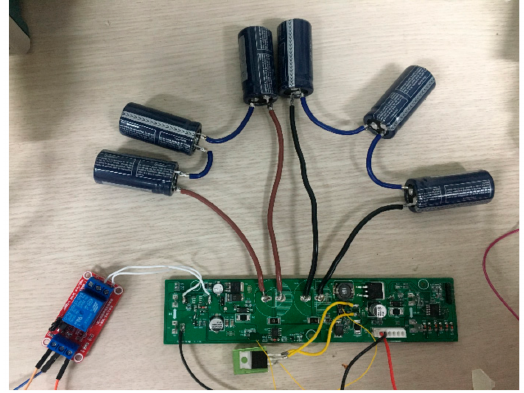
Figure 5. PCB board with Supercapacitors.